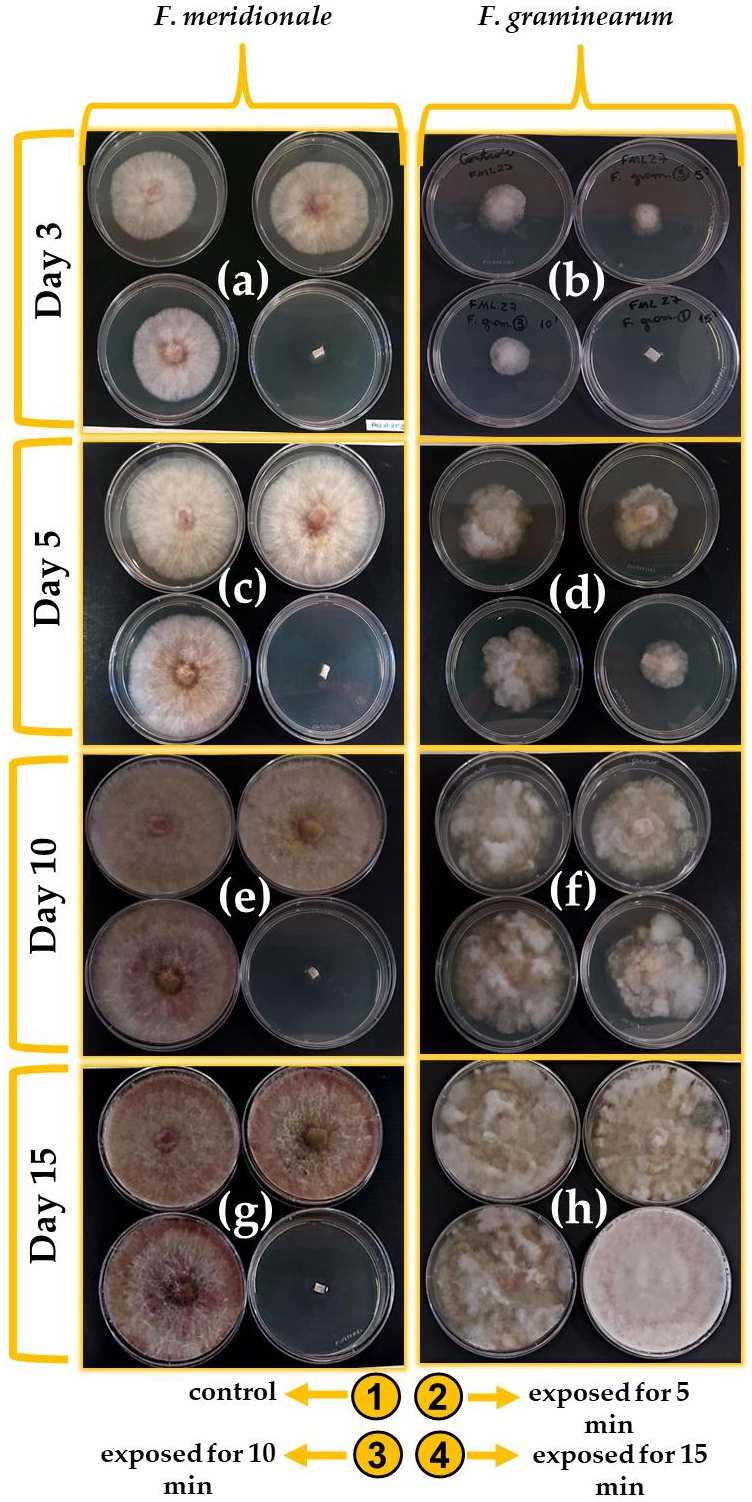
Figure 4. Monitoring the radial growth of the fungi F. meridionale (FML03) and F. graminearum (FML08) at 25 °C for 3, 5, 10, and 15 days. ( a , c , e , g ) F. meridionale treated by GAPJ for 5, 10, and 15 min. ( b , d , f , h ) F. graminearum treated by GAPJ for 5, 10, and 15 min.